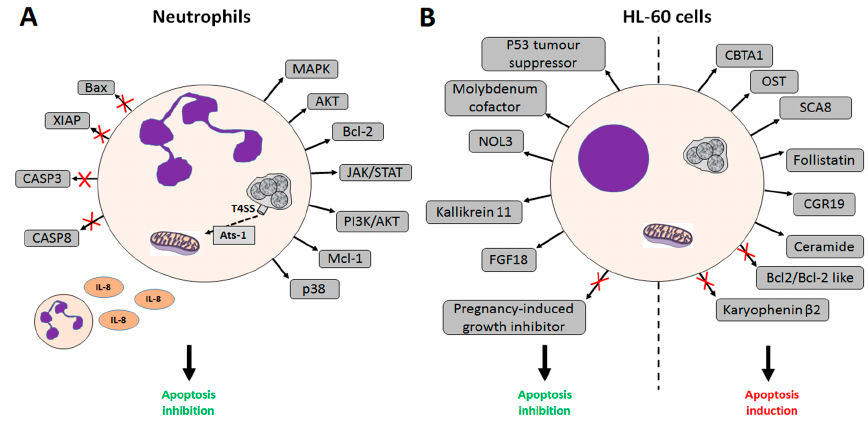
Figure 1. Effects of A. phagocytophilum infection on apoptosis pathways in human cells. ( A ) Effects